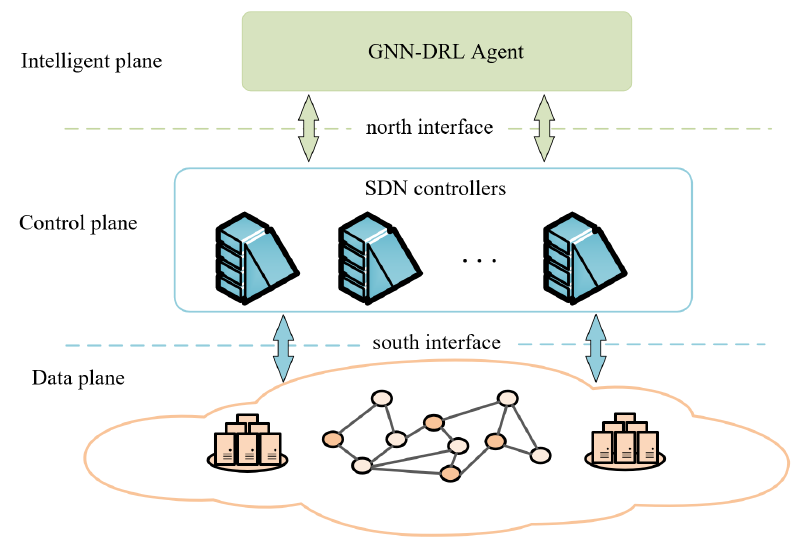
Figure 2. GNN-DRL intelligent routing framework.